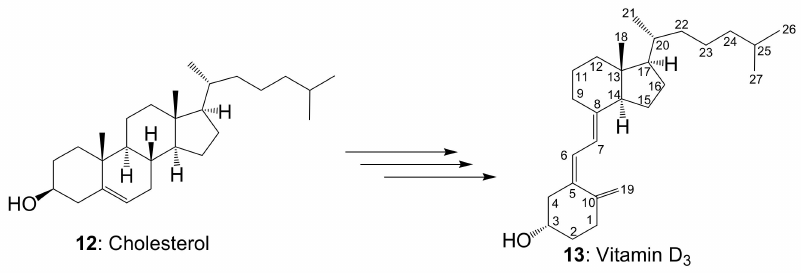
Figure 5. Vitamin D 3 synthesis for comparative analysis by NMR. Synthesis of vitamin D 3 ( 13 )